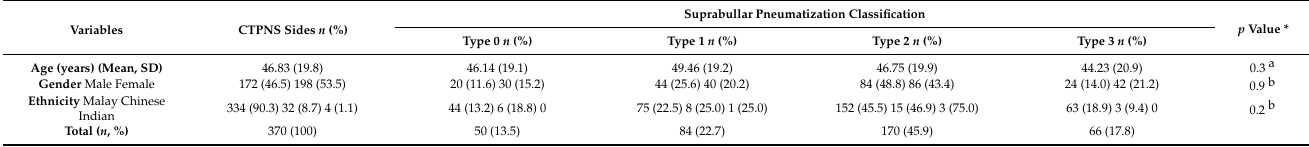
Table 1. Distribution of suprabullar pneumatization according to patient